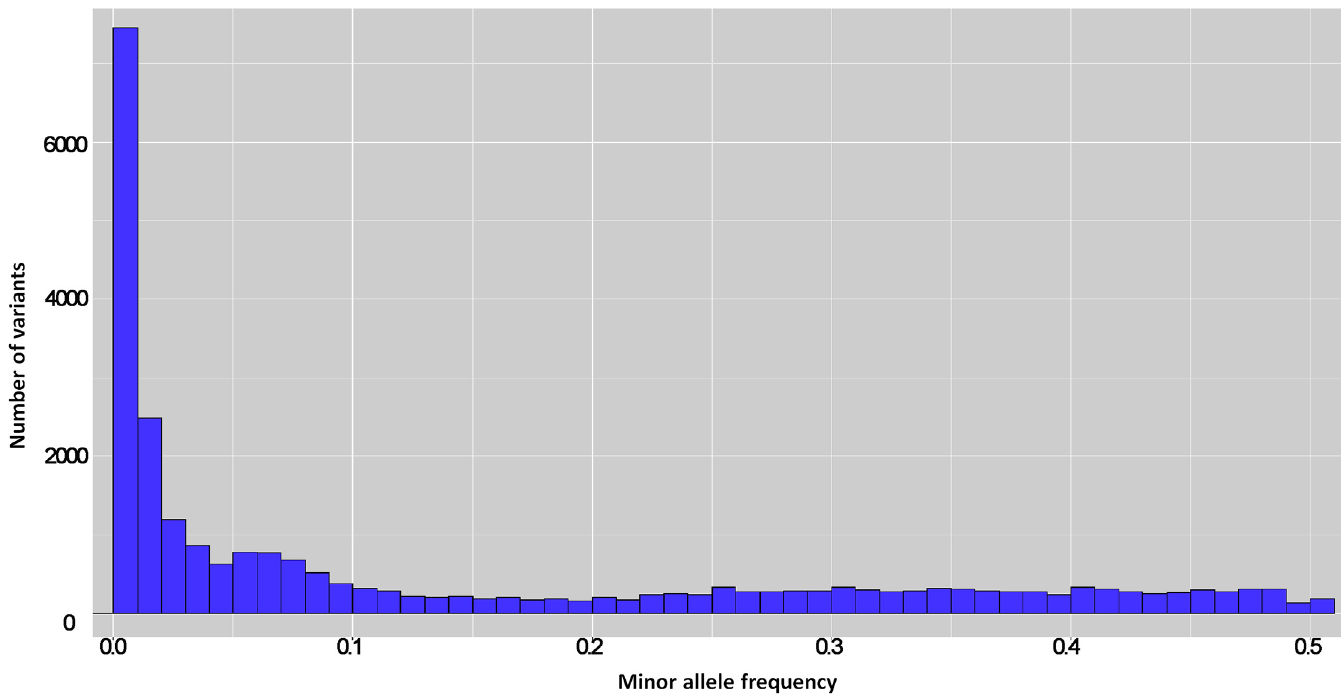
Fig 3. The distribution of minor allele frequency of valid variants calls by genotyping by sequencing.